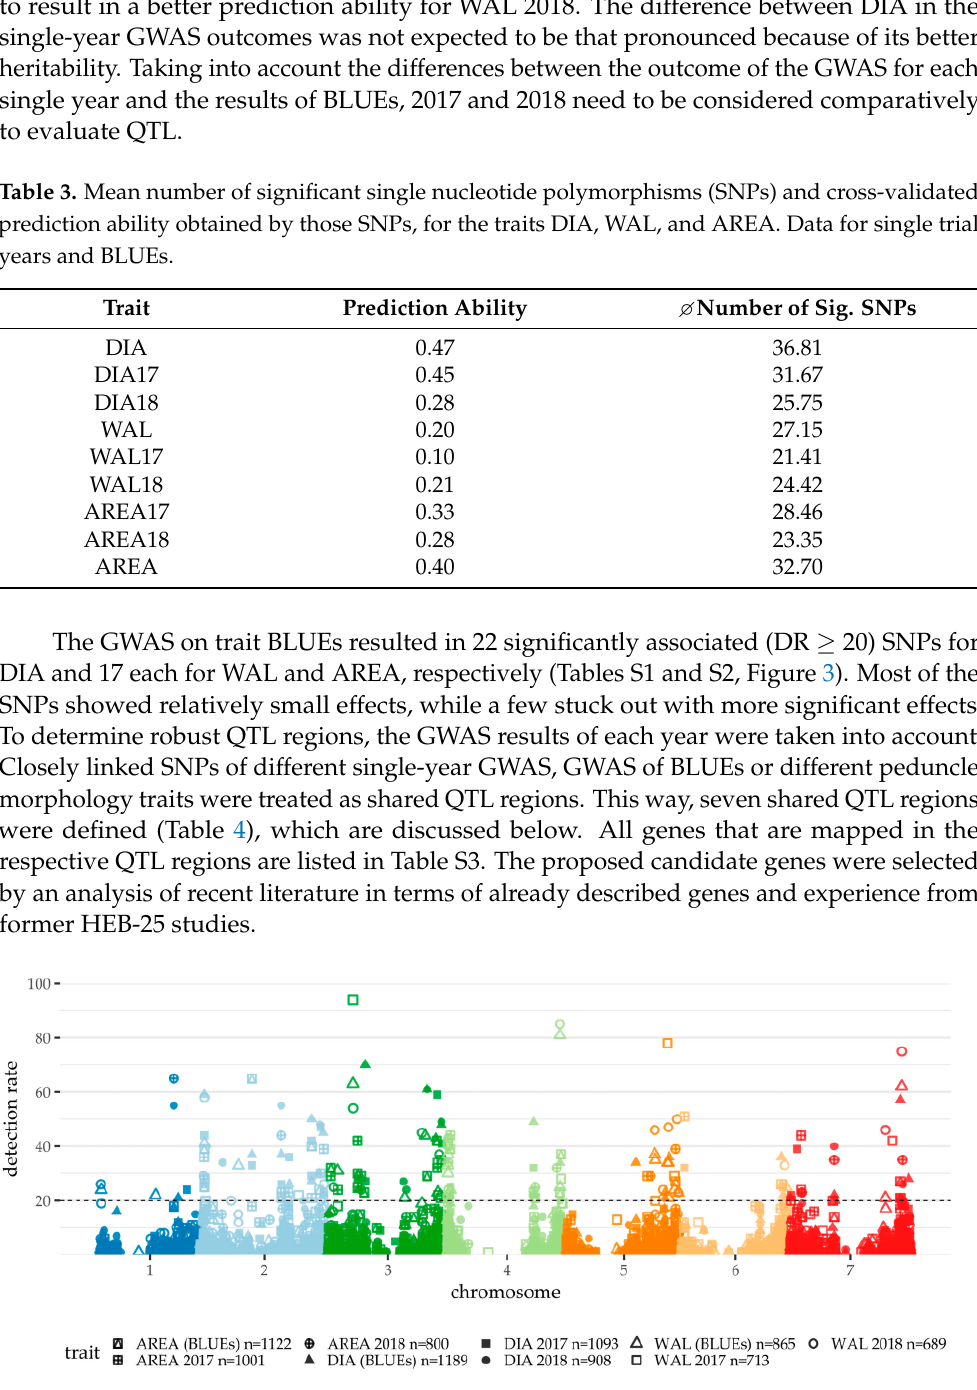
Figure 3. Manhattan plot summarizing cross-validated genome-wide association study (GWAS) results of peduncle morphology traits 2017 and 2018. The physical SNP positions were taken from [18]. The different point shapes and fillings differentiate the traits and years. The detection rate (DR) in 100 cross-validation runs is given on the y-axis. The dashed line indicates the threshold of DR > 20, which was used as significance threshold. Markers without any detections are not displayed in the